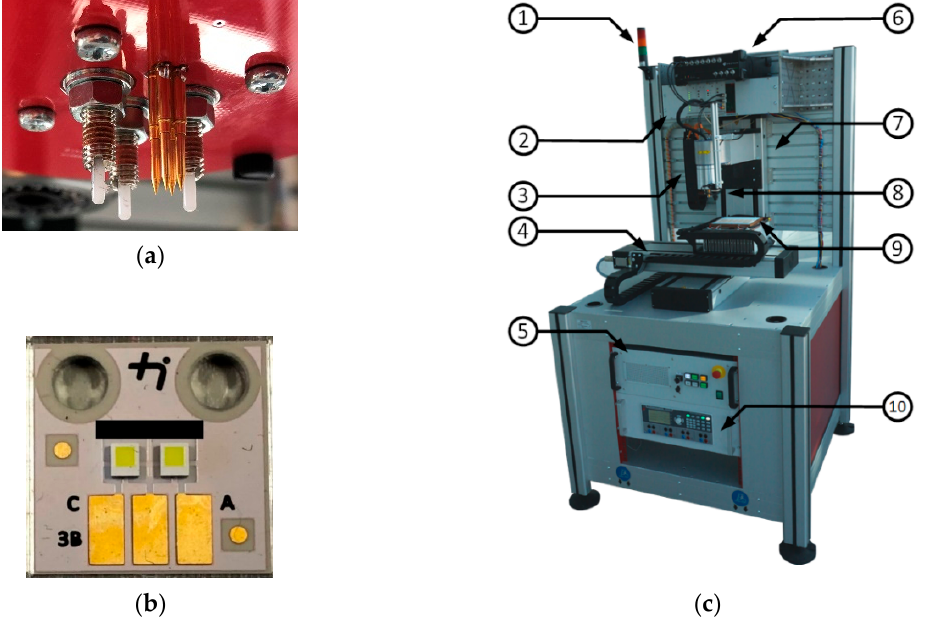
Figure 5. ( a ) Probing adapter with four spring probes for electrical connection and three harder springs to increase clamping force. ( b ) Example of a substrate with two devices under test (DUTs) and three probing pads. ( c ) Automatized thermal impedance measurement equipment (ATIM) with subsystems (1: signal column; 2: heat / sense power source; 3: rotation axis with integrated force sensor and